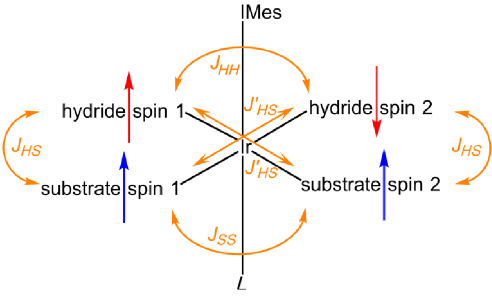
FIG. 8. A simplified spin system that promotes spin-order transfer on the SABRE catalyst. The J -coupling values are as follows: J HH ≈ − 7 Hz, J (cid:6) J HS ≈ 0